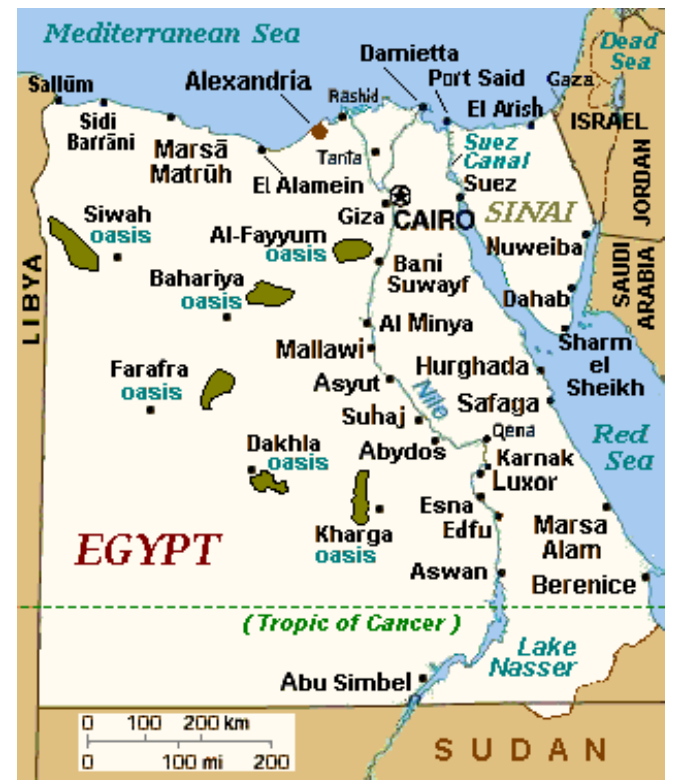
Figure 1. Location of Lake Nasser,